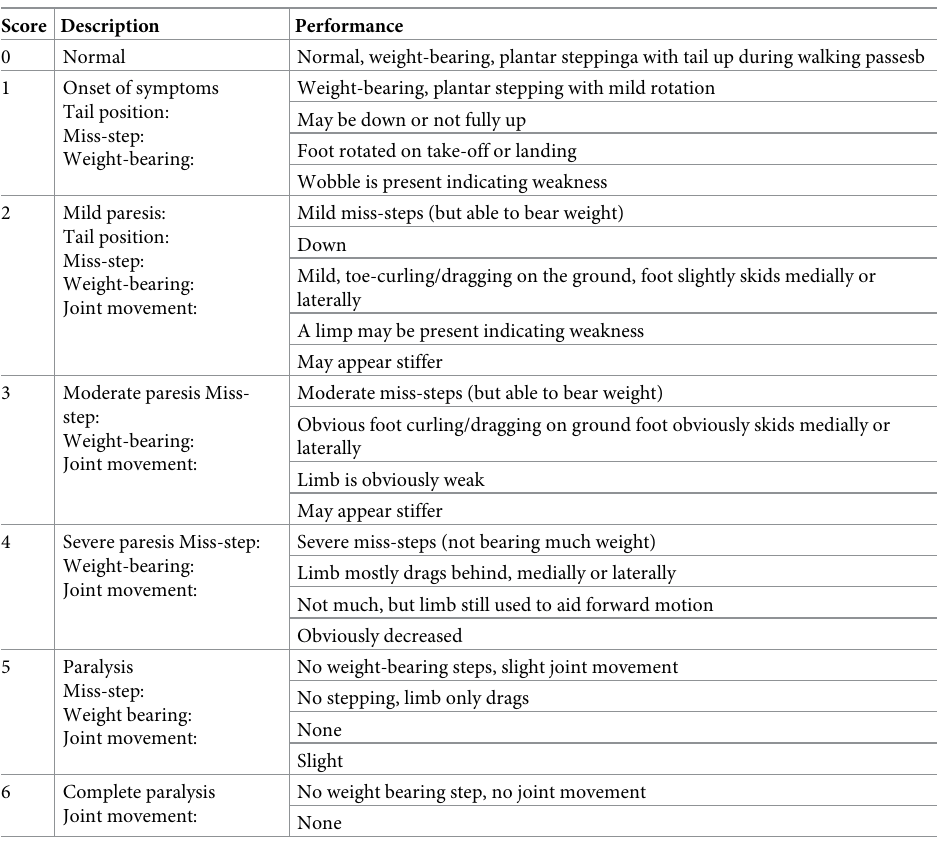
Table 1. Viral paralysis scale